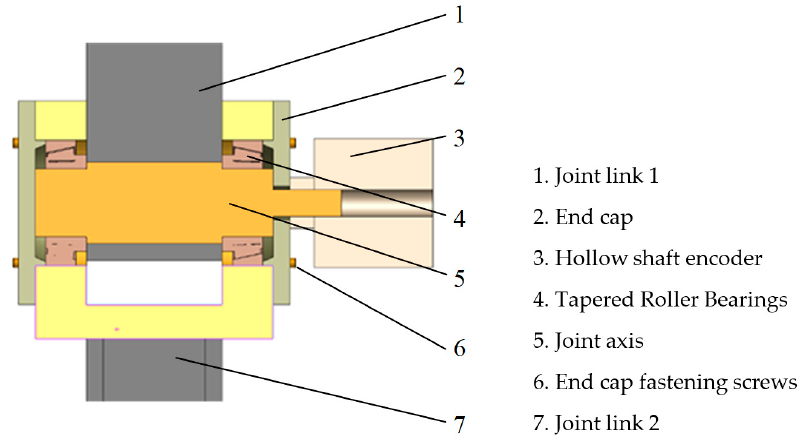
Figure 2. Modular joint axis structure.